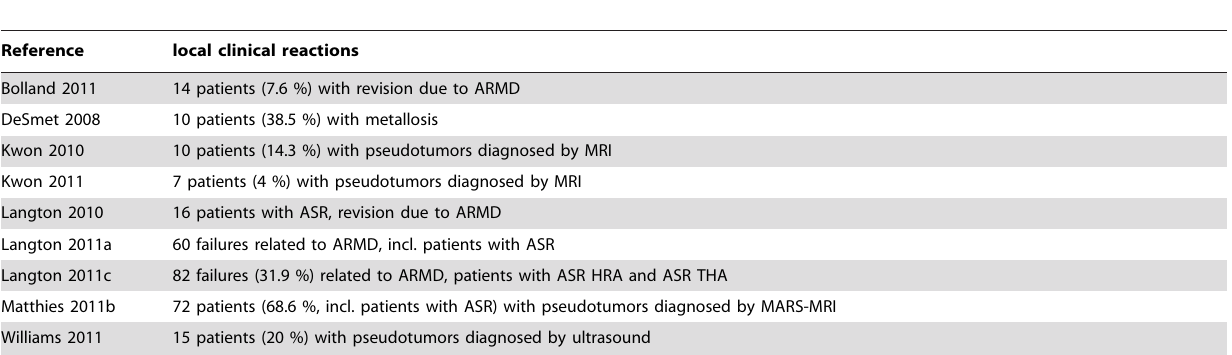
Table 12. Documentation of local metal-related adverse reactions.